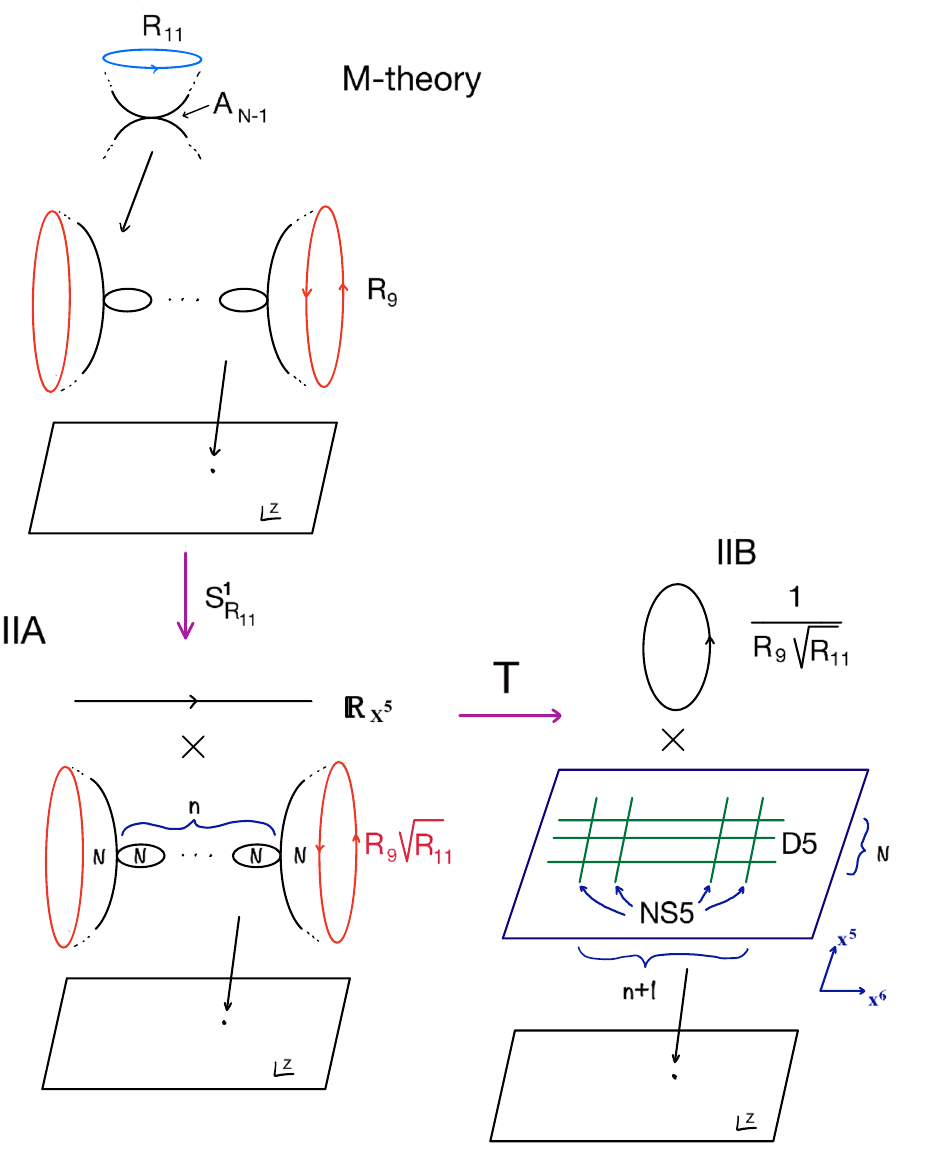
Figure 5 . IIA on an ALF space. (The z -plane is spanned by the coordinates x 7 ; x 8 , while the C (cid:3) -(cid:12)ber of the ALF space is spanned by x 6 and the circle coordinate x 9